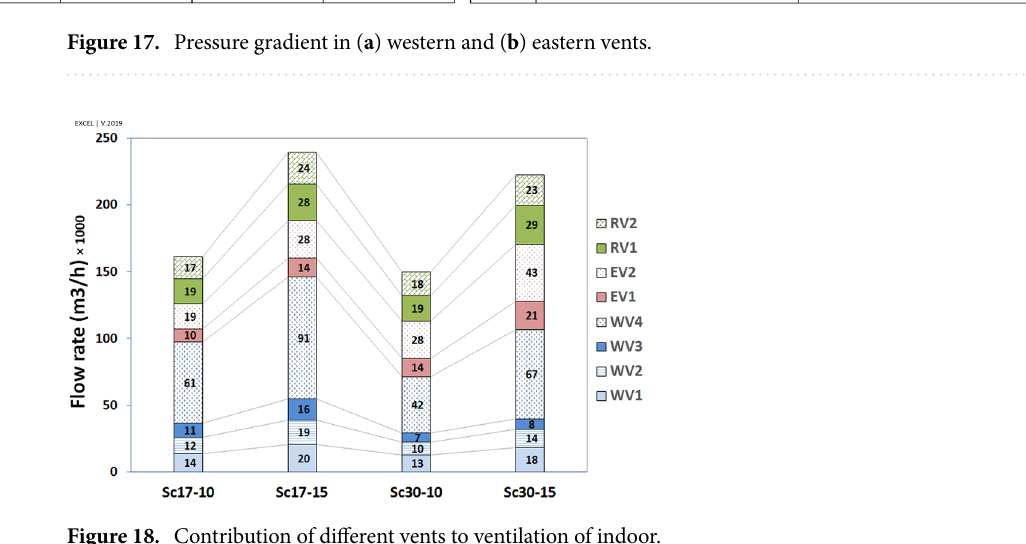
Figure 18. Contribution of different vents to ventilation of